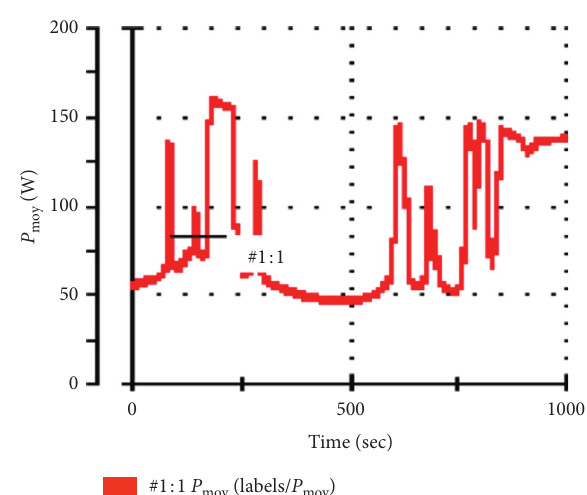
Figure 32: Evolution of operating point in P